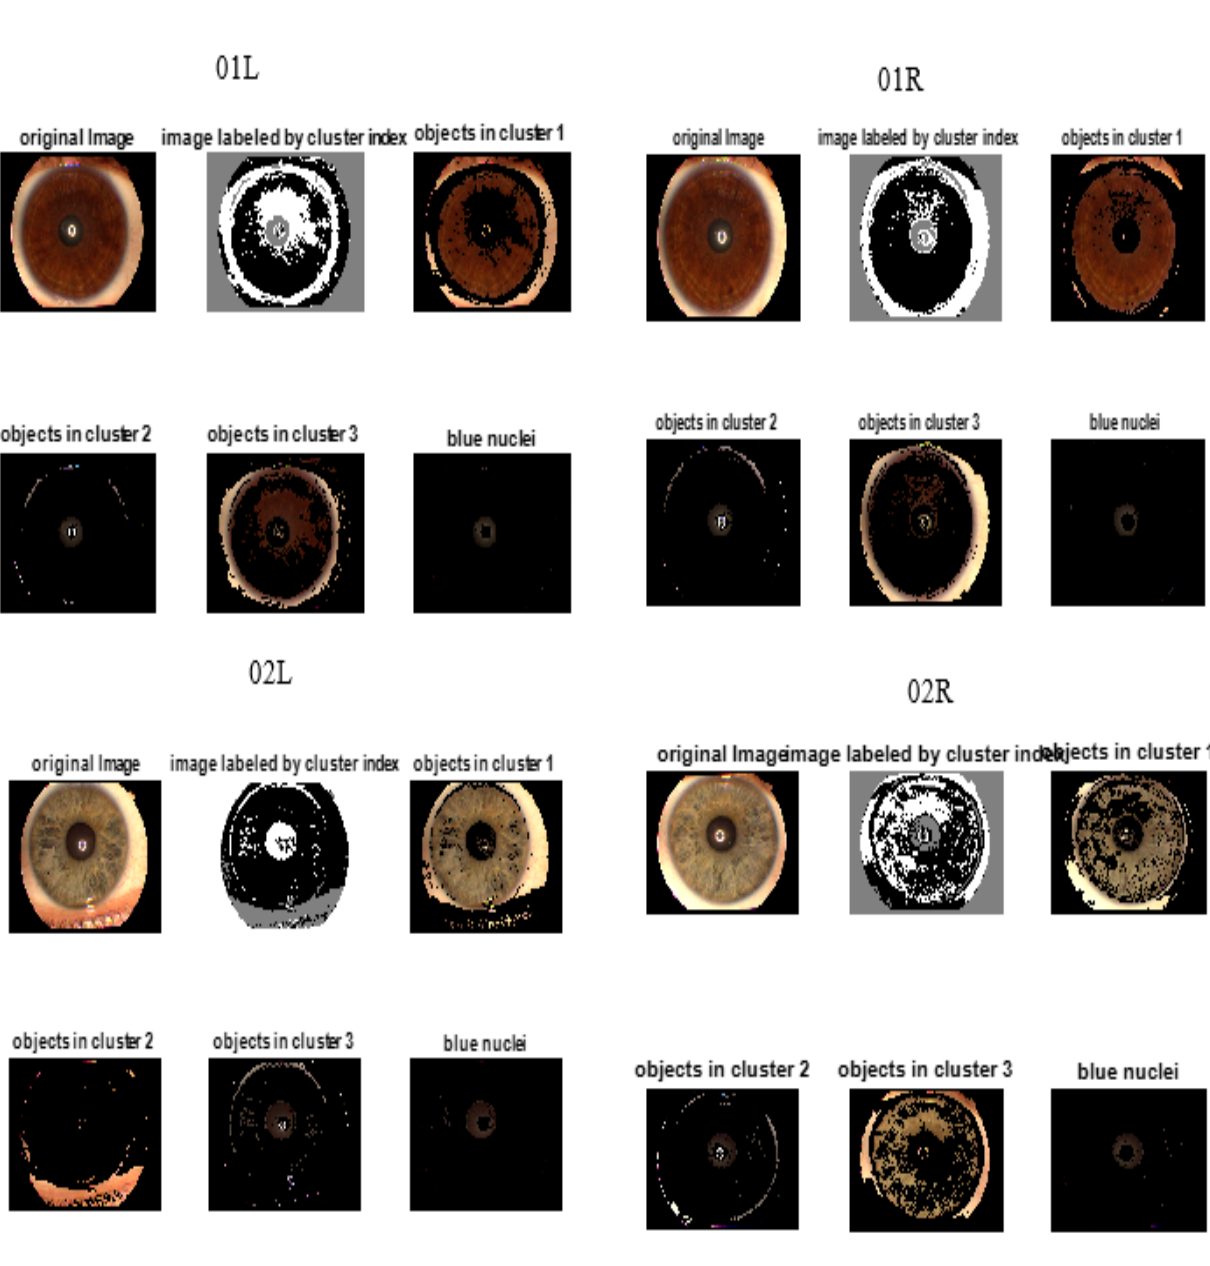
Figure 3. Clustering steps (left and right iris,